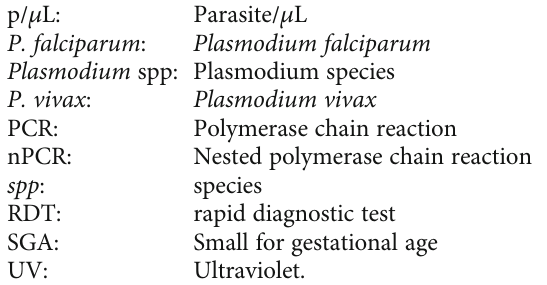
Supplementary Table 1: sequence of the primers used in the nested polymerase chain reaction (nPCR) assay. Supplemen- tary Table 2: frequency of Plasmodium spp infection and anaemia among the municipalities. (Supplementary